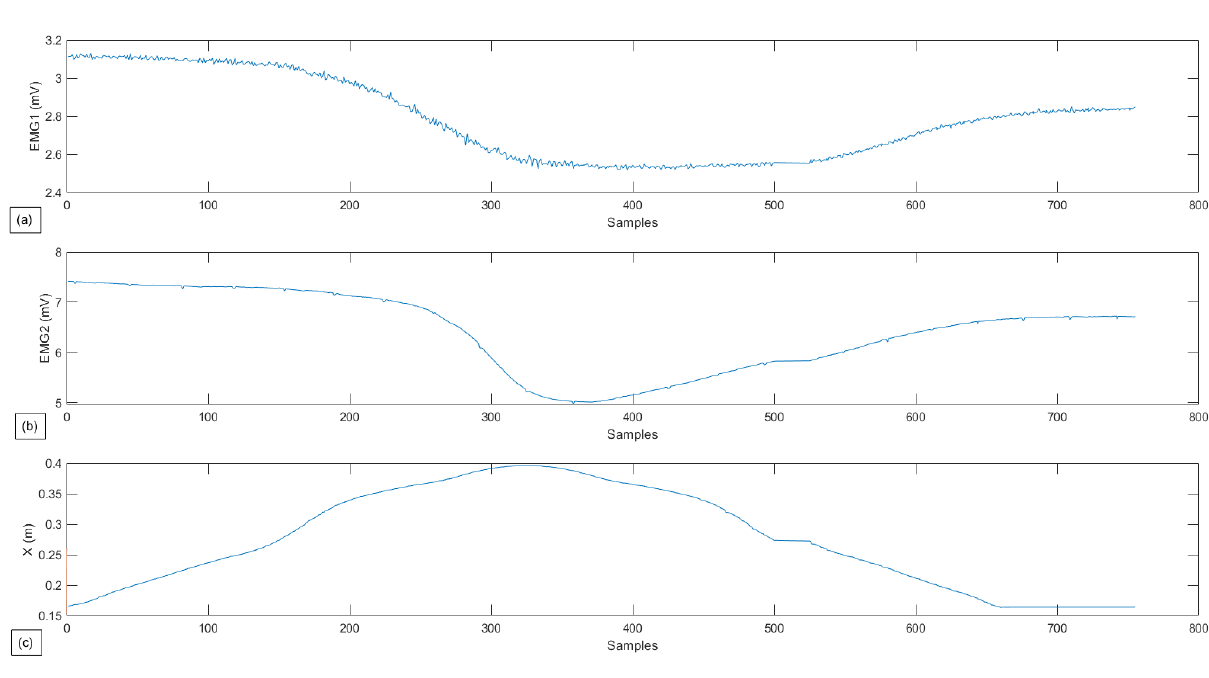
Figure 10. Experimental test for passive Lateral Shoulder Rotation. ( a ) Muscle activity for the Deltoid muscle. ( b ) Muscle activity for the Latissimus Dorsi. ( c ) Robot position in x in relation to the